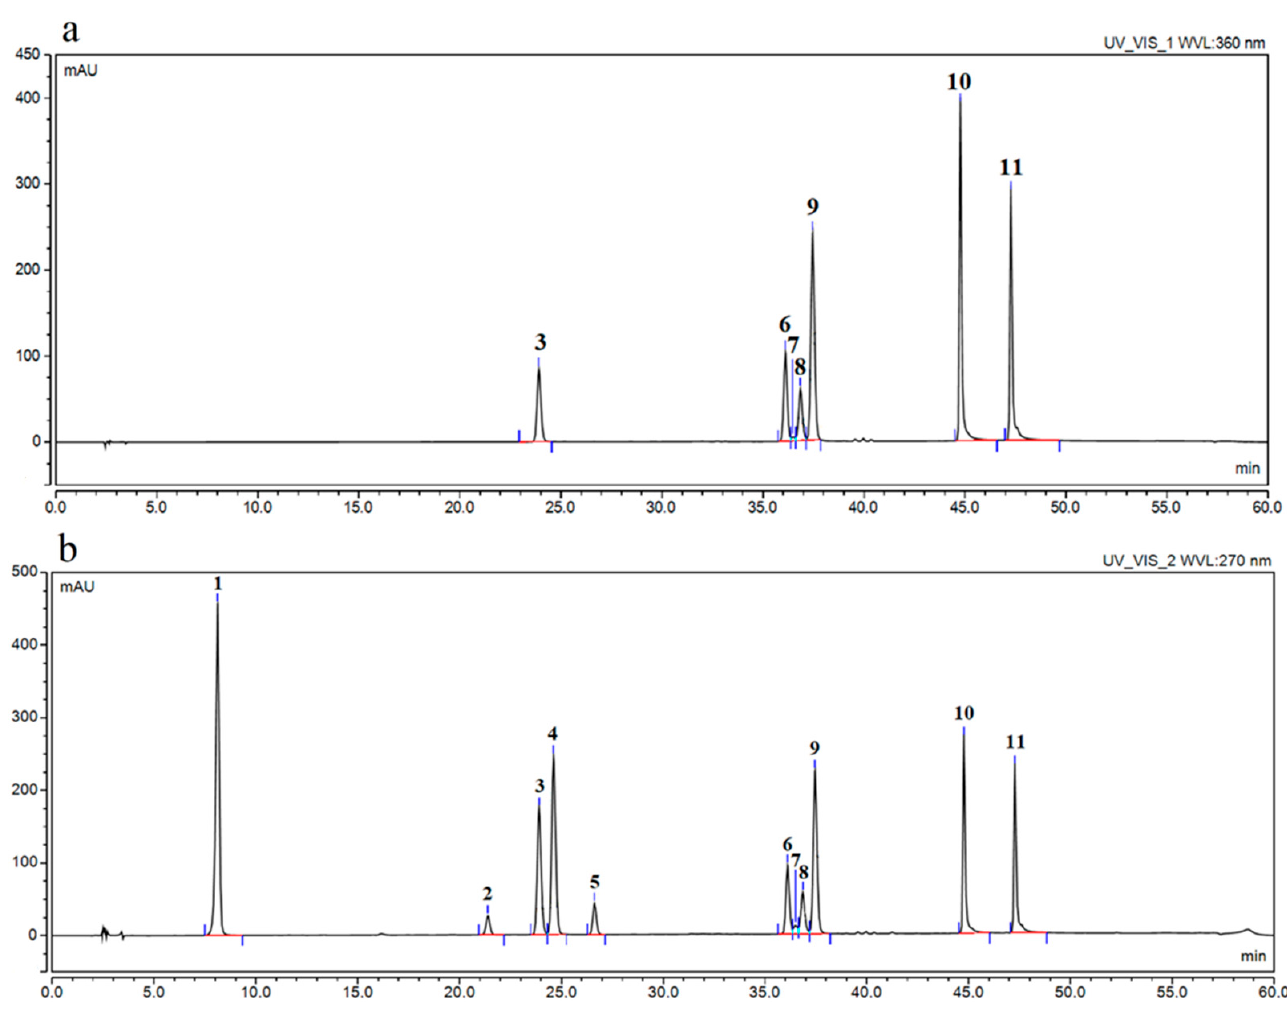
Figure 1. Chromatogram of phenolic compounds identified in blackberry leaves Loch Tay extracts: 1—gallic acid, 2—catechin, 3—caffeic acid, 4—syringic acid, 5—epicatechin, 6—rutin, 7—ellagic acid, 8—hyperoside, 9—isoquercetin, 10—quercetin, 11—kaempferol, at 360 nm ( a ) and 270 nm ( b ). Table 2. The content of phenolic compounds in blackberry leaves aqueous and hydroalcoholic extracts.